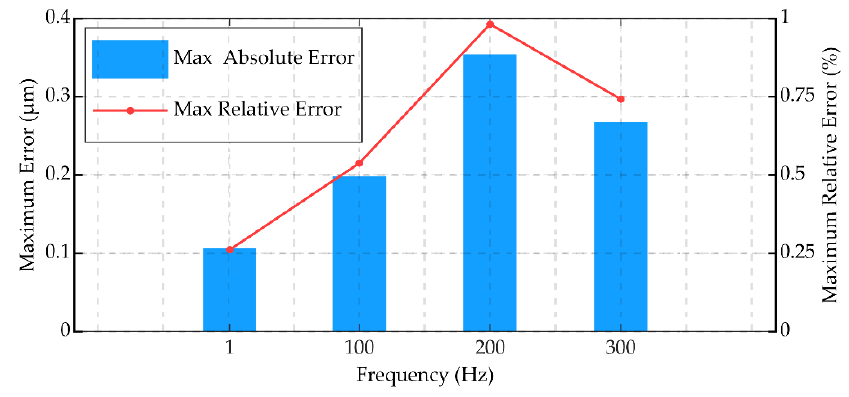
Figure 7. FVPI model error evaluation at different frequencies.